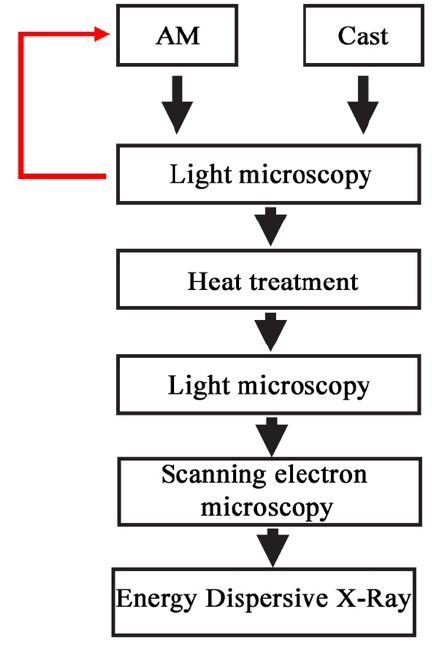
Figure 4. Microscopic examination schedule.